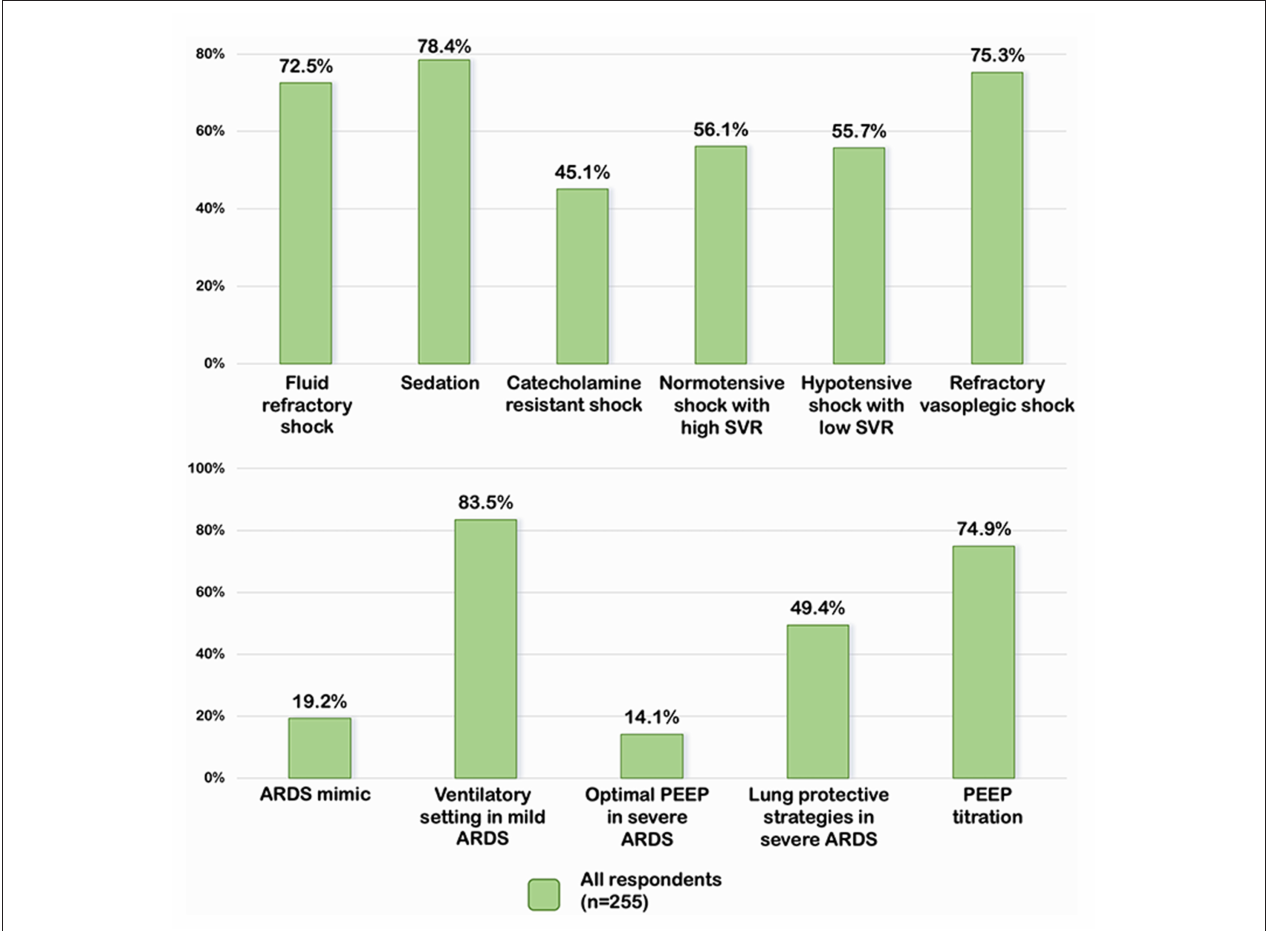
FIGURE 1 | Percentage of appropriate answers on septic shock and pARDS in all respondents. SVR, systemic vascular resistance; PEEP, positive end expiratory pressure; ARDS, acute respiratory distress